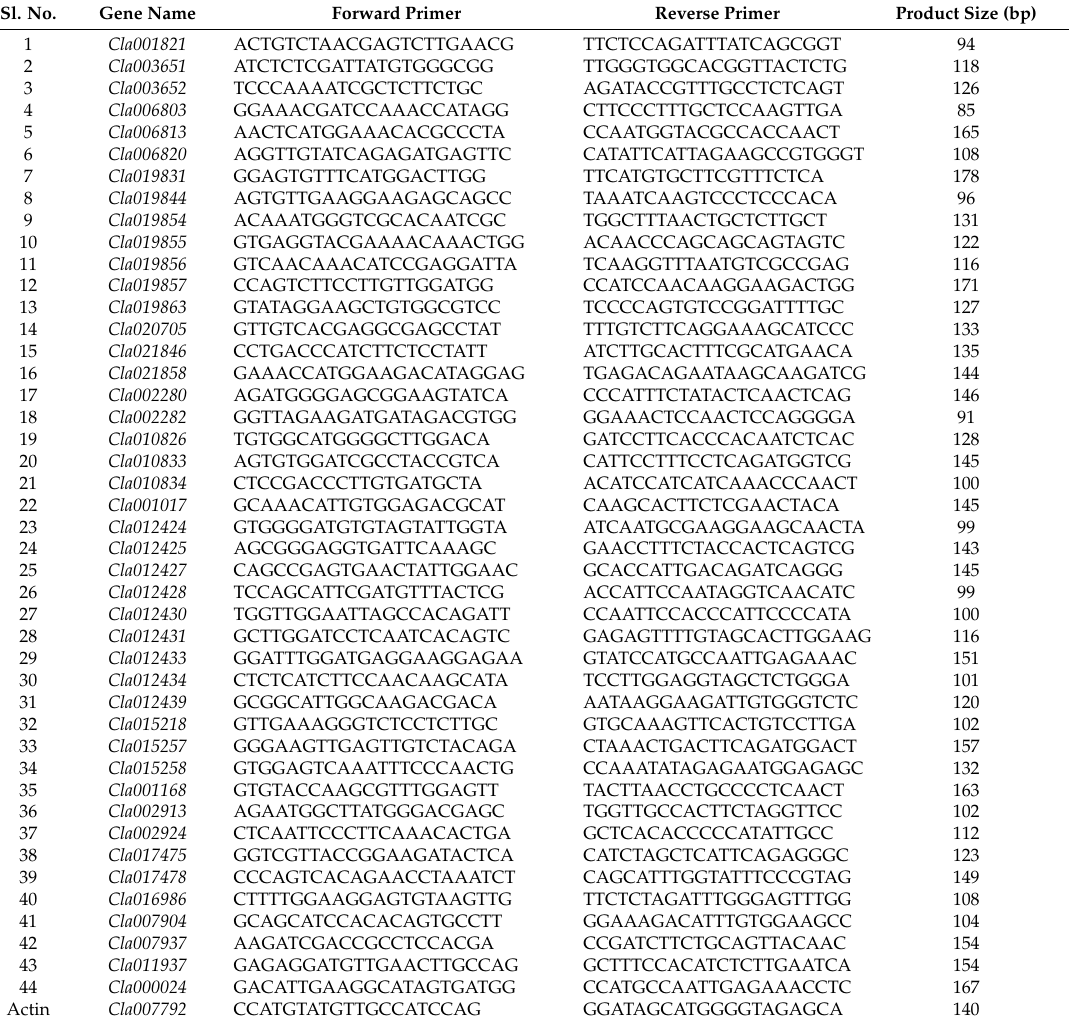
Table 5. Primers for the 44 NBS-encoding genes in watermelon. Sl.